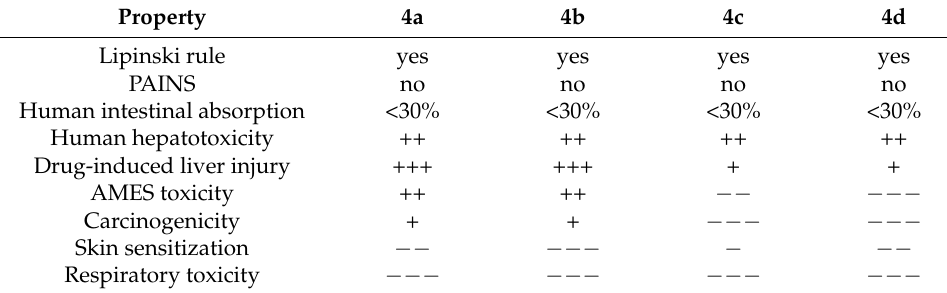
Table 4. ADMET predictions for the new